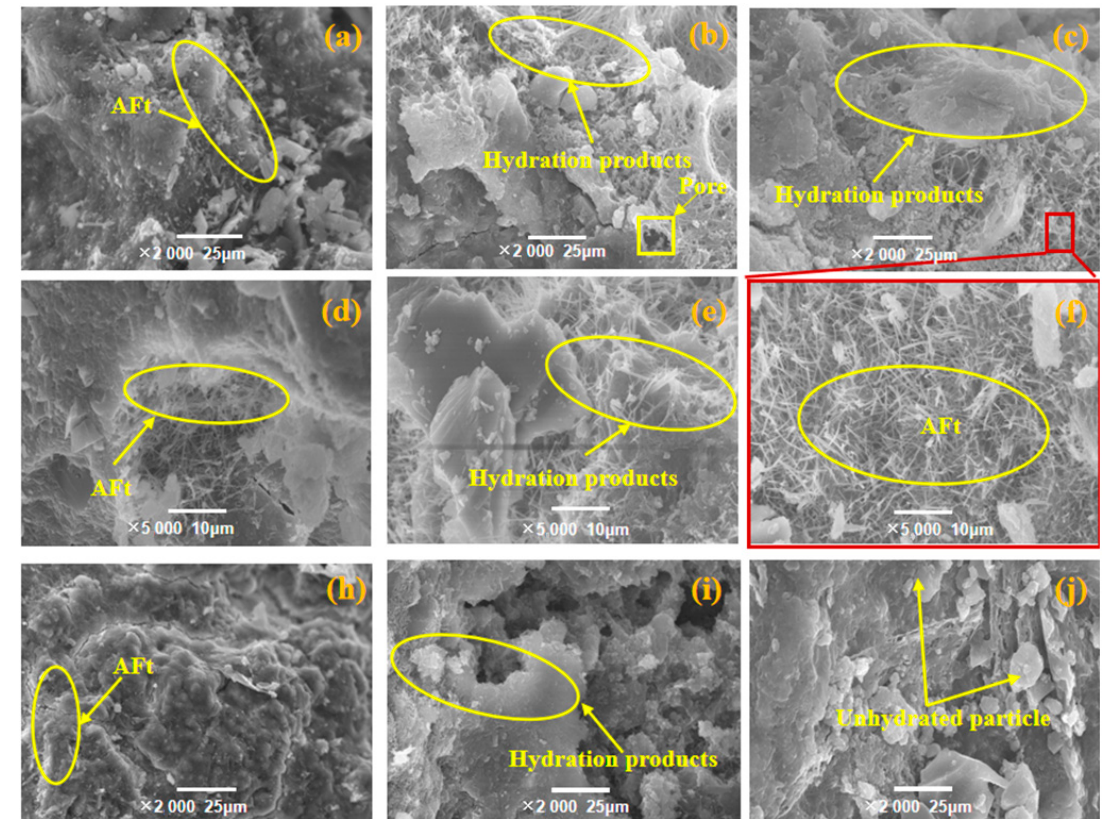
Figure 8. Microstructure of C85ITP15 under ( a ) standard curing; ( b ) warm-water curing and ( c ) steam curing at 7 days; ( d ) 5000 times magnification of the sample C85ITP15 under standard curing; ( e ) partially enlarged view for the C85ITP15 under warm-water curing and ( f ) partially enlarged view for the sample C85IP15 under steam-curing (red square); The sample C85ITP15 under ( h ) standard curing; ( i ) warm-water curing and ( j ) steam curing at 28 days. AFt refers to the ettringite.